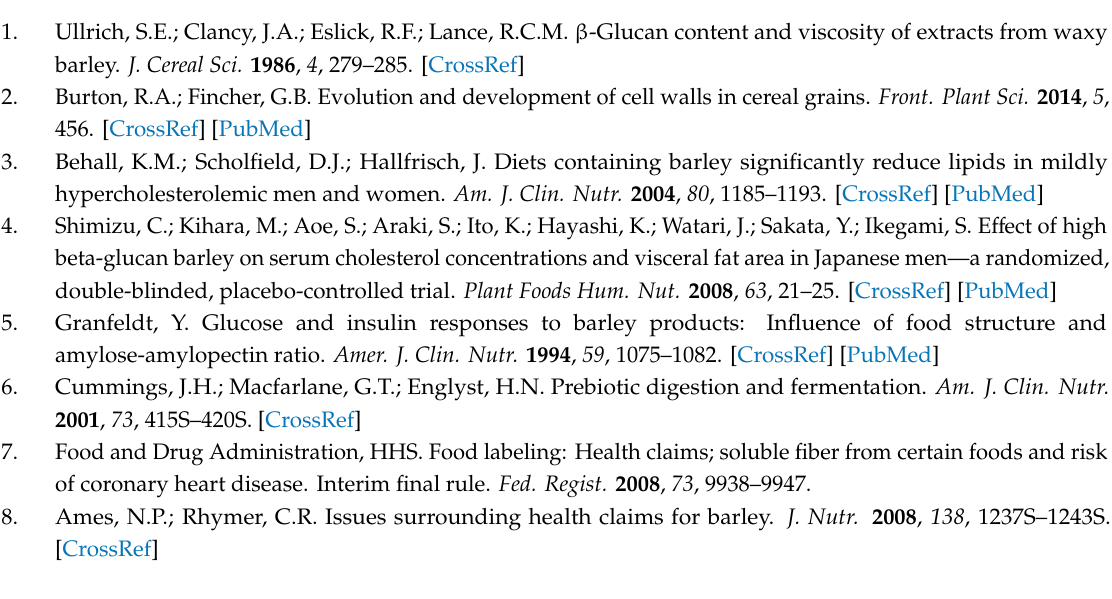
Table S1: Nutrient composition of experimental